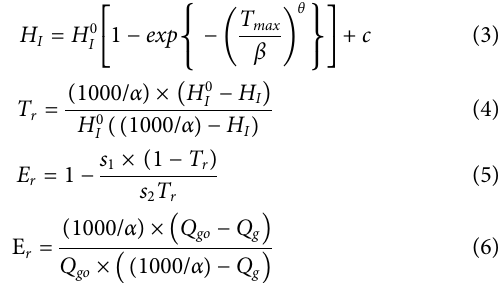
Frontiers in Earth Science |